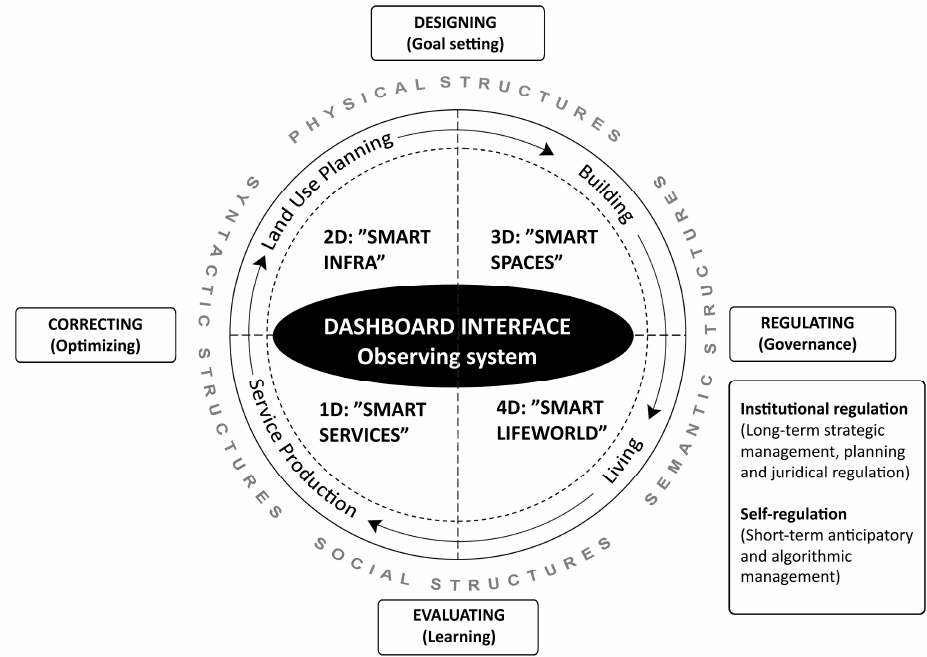
Figure 1. The dimensions of smart city services, infrastructures, spaces, and lifeworld, intertwined.